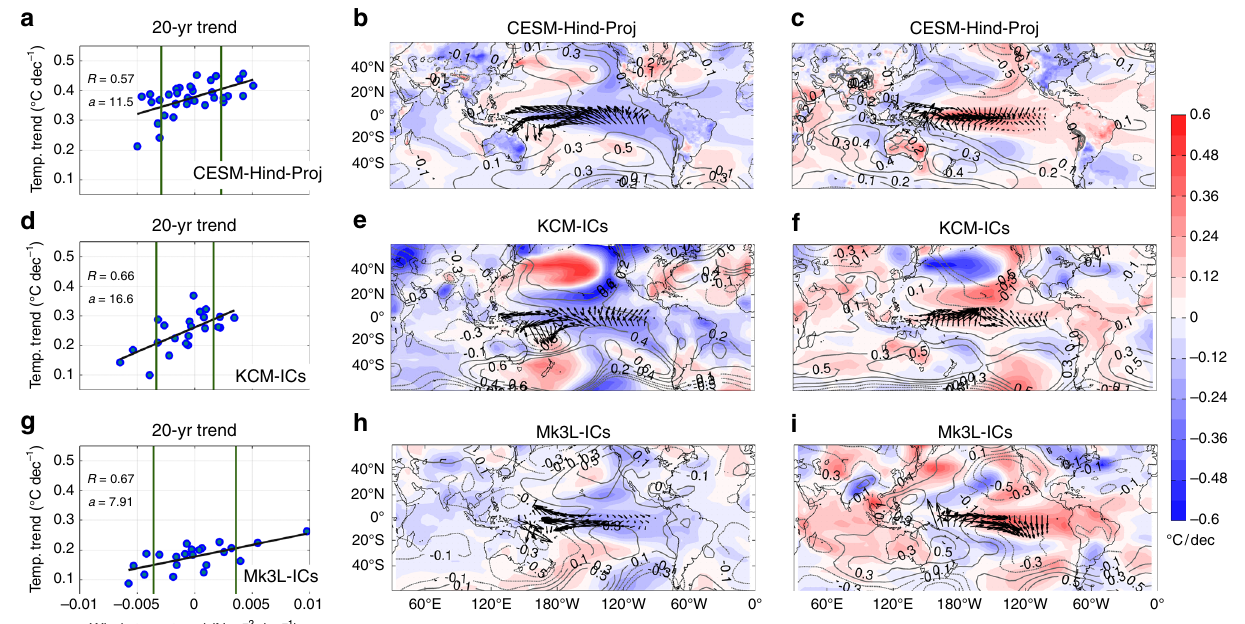
Fig. 4 Composites of 20-year trends in SAT, SLP, and Paci fi c trade winds in three ensembles of a global warming simulation. a , d , g Scatter plot of 20-year trends in equatorial Paci fi c zonal wind stress (Nm − 2 /decade) and globally averaged SAT (°C/decade) from individual ensemble members (left panels). The vertical solid lines indicate the mean ± Std of the trend in the wind stress and black solid lines denote the regression lines between GMT and wind stress trends. The correlation between the wind stress and GMT trends and the slope of the regression lines are shown with R and a in the left panels. Other panels show composites of 20-year trends in SAT (shading; °C/decade), SLP (contours; hPa/decade), and wind stress (arrows; Nm − 2 /decade) based on ensemble members with wind stress trends less than ( b , e , h ) or exceeding ( c , f , i ) 1Std from CESM1-Hind-Proj ( a – c ) the KCM-ICs ( d – f ), and the Mk3L-ICs ( g – i ) ensemble of global warming simulations. a – c The trend is computed for the period corresponding to 2016 – 2035, whereas in d – i it is related to the fi rst 20-year of the realizations. The corresponding ensemble mean SAT trend is subtracted from each grid point in b – c , e – f , h –